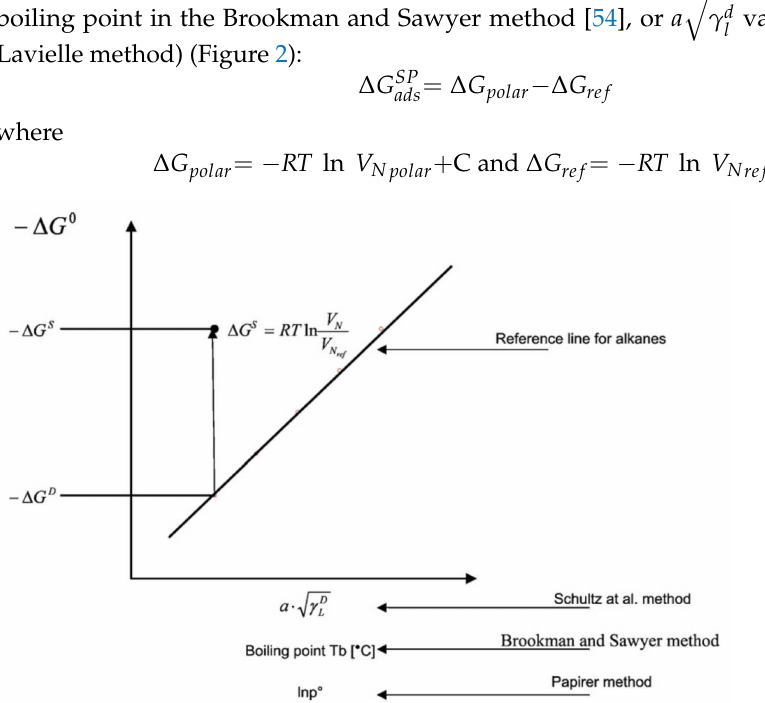
Figure 2. Different procedures for ∆ G SP Copyright (2009)